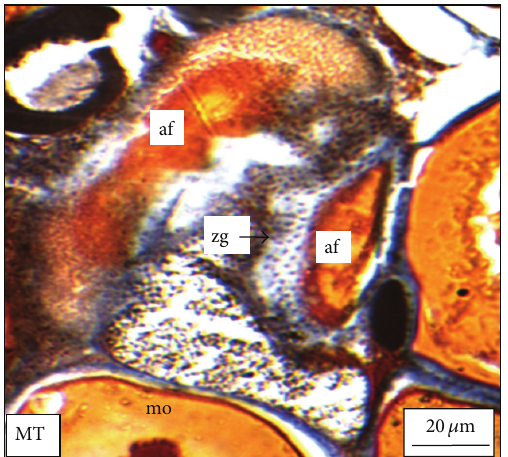
Figure7:Thehistologicalsectionoftheovaryofa M.tengara during the early spawning phase (June) showing mature oocytes undergo- ing apoptosis and showing liquefaction of the yolk materials along with hypertrophy of the granulosa cell (zg) [HE: Haematoxylin- Eosin